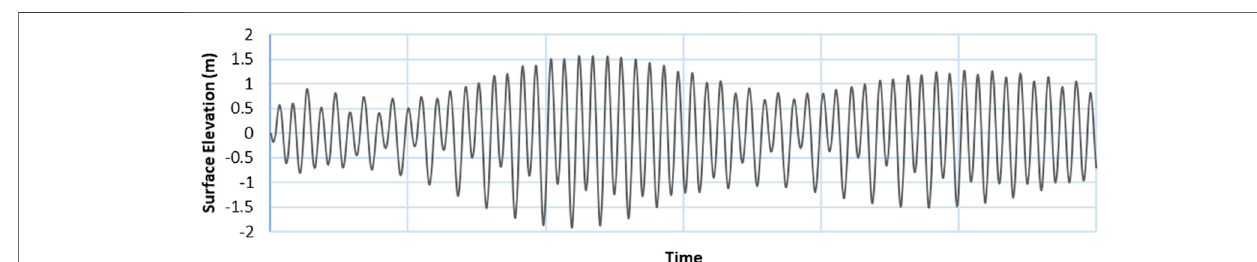
FIGURE 12 | Surface elevation pro fi le of Singapore location.